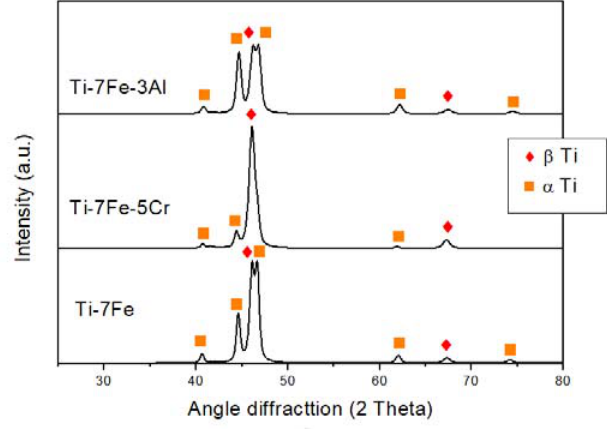
Figure 5. XRD patterns of as-sintered Ti alloys.